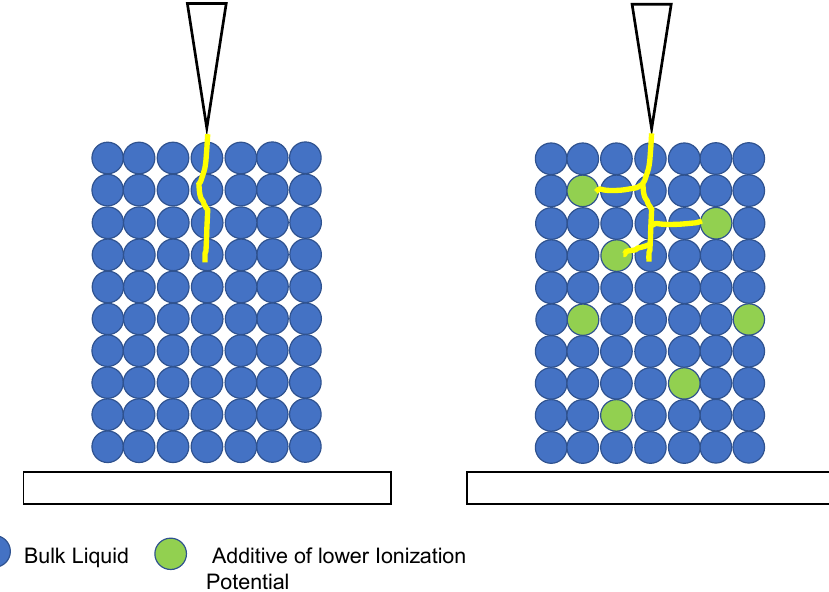
Figure 5. A simplified illustration postulating how a lower IP additive may promote streamer